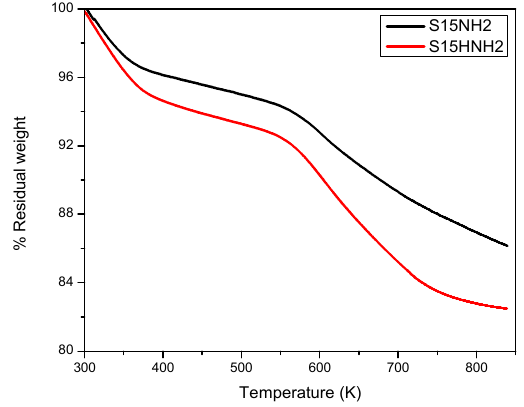
Figure 5. Thermogravimetric analysis, under N 2 flow, of the S15NH 2 and S15HNH 2 APTES-functionalized silica specimens.